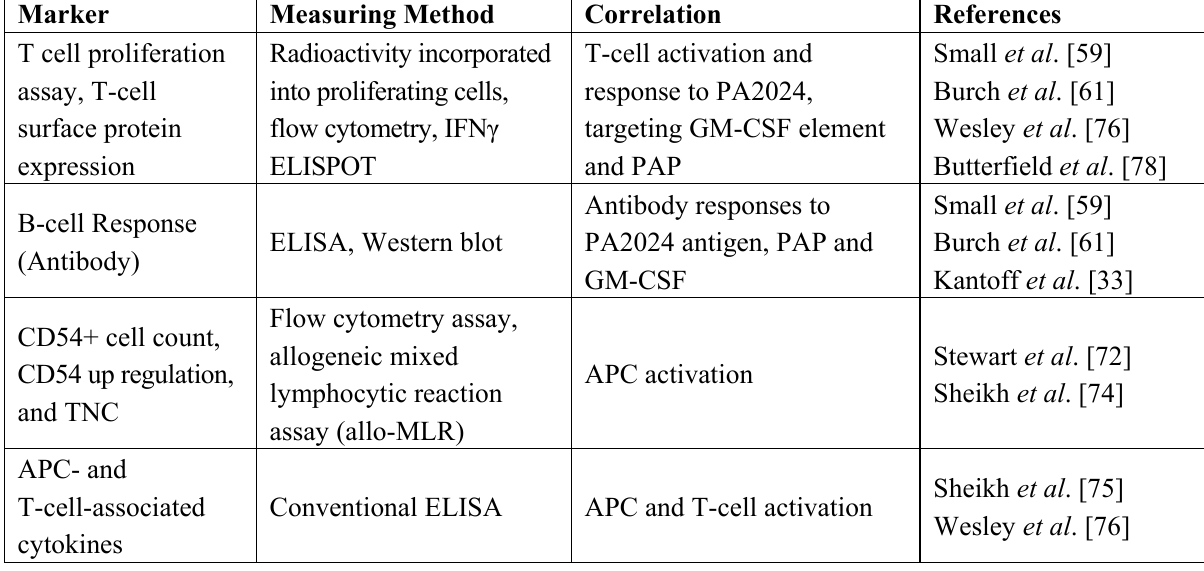
Table 2. Immune response and monitoring